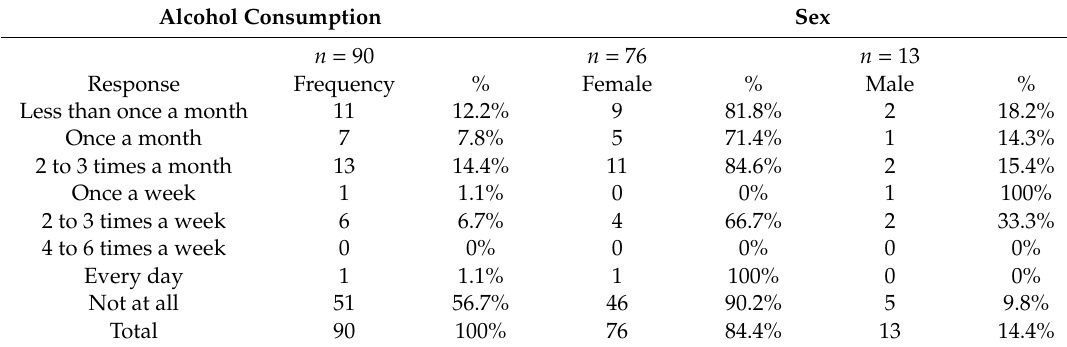
Table 5. Alcohol consumption by sex.